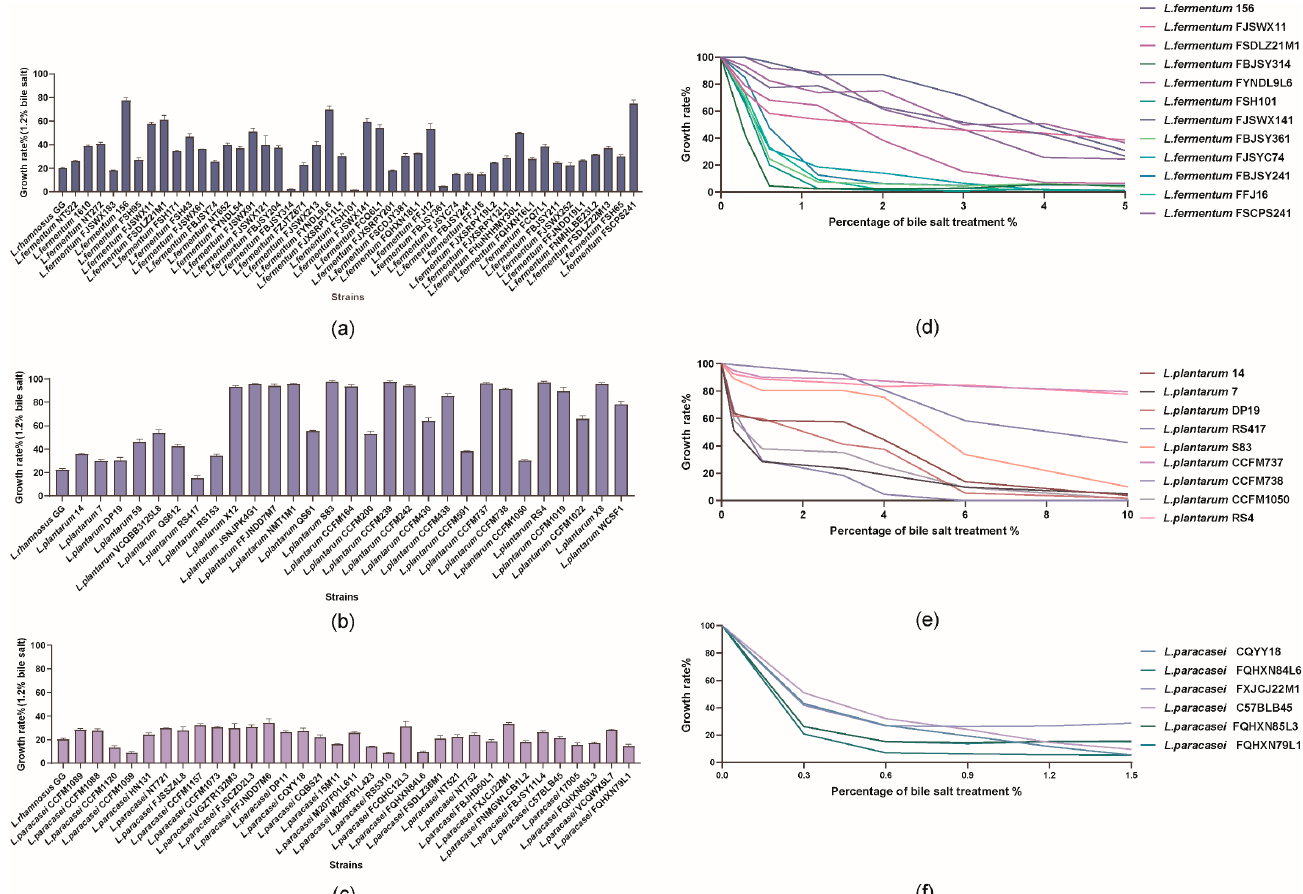
Figure 1. Growth rate of lactobacilli following 12 h incubations under bile salt conditions. ( a ‒ c ) Growth rate of L. fermentum , L. plantarum , and L. paracasei in the presence of 1.2% bile salt, respectively. ( d ‒ f ) Growth rate of L. fermentum , L. plantarum , and L. paracasei in the gradient bile salts, respectively. The experiments were performed in triplicate, and the results are expressed as mean ± SEM.